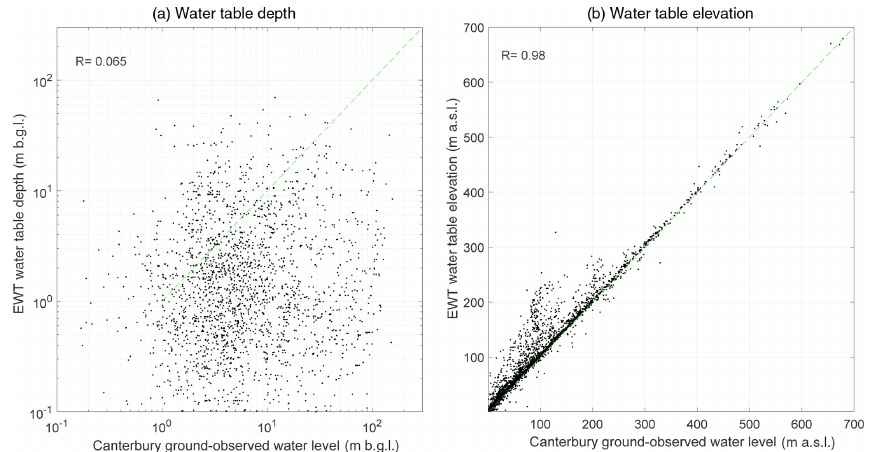
Figure 10. Correlation of EWT water table depth and water table elevation with ground observations in the Canterbury region. The dashed line is the 1 : 1